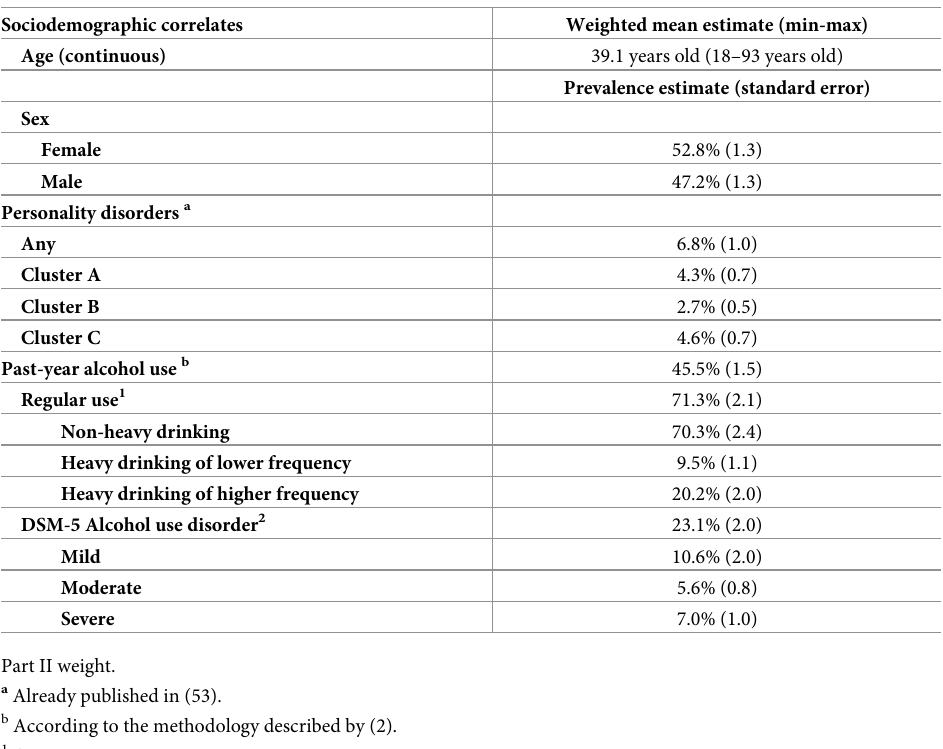
Table 1. Weighted mean of age and weighted prevalence estimates of sex, lifetime personality disorders and past- year alcohol use, drinking patterns and alcohol-use disorder in the S ã o Paulo Metropolitan Area, Brazil (N =